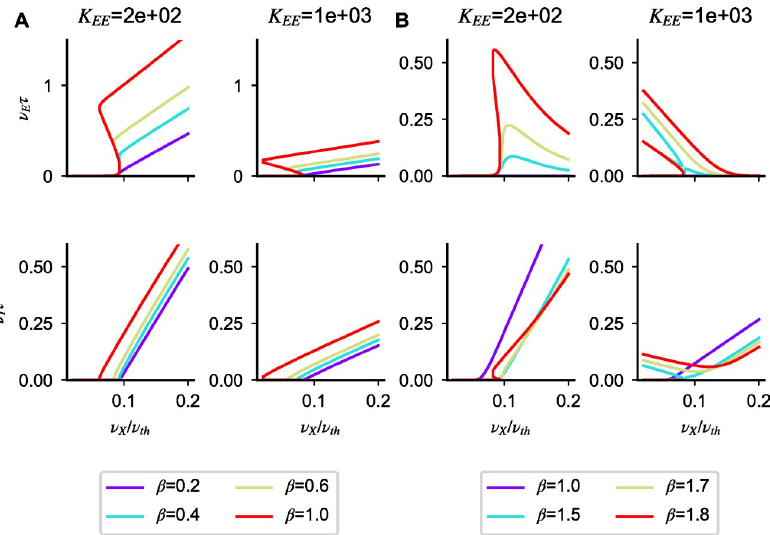
Fig 6. Onset-nonlinearities in model B. Responses obtained solving numerically Eqs (3)–(5) for regular ( A ) and supersaturated ( B ) solutions at different coupling strengths and for different β = K nonlinear region decreases as the coupling strength increases and as the inhibitory activation threshold decreases. In B, the lack of purple curve in the first row means that the firing rates are very close to zero in the whole range of inputs. In the plots, response onset emerges around 0.1 ν showed in Fig 5F, this choice enhances the amplitude of the nonlinear region by decreasing the likelihood of having multiple solutions. Other simulation parameters are:, J α I = 10, α E =